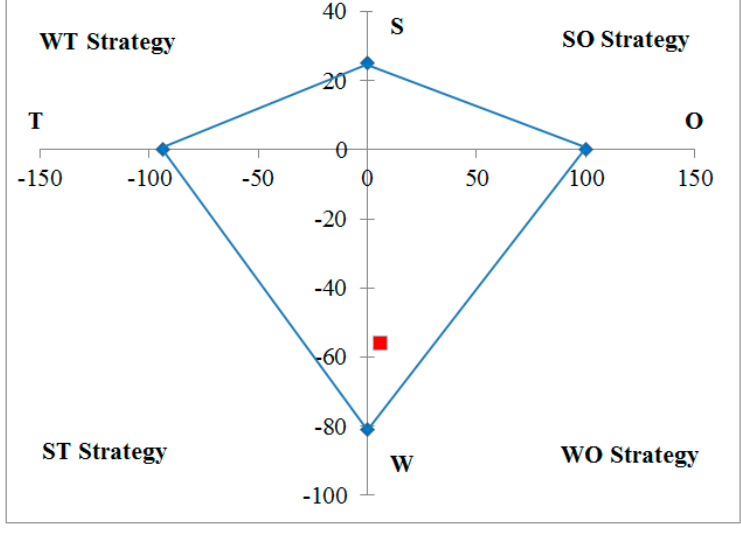
Figure 2. SWOT analysis—strategic alternatives for forestry contractor firms.